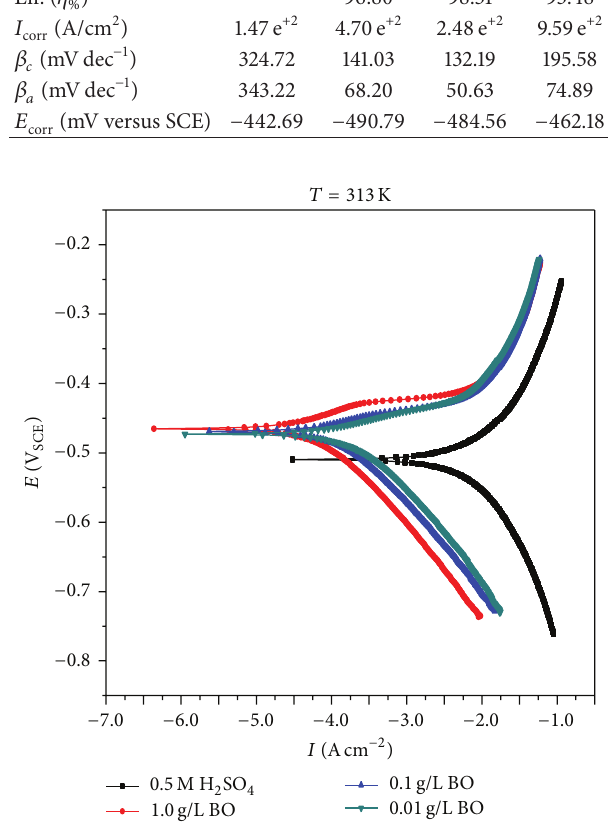
Figure 2: Potentiodynamic polarization curve for pipeline steel in 0.5 M sulfuric acid with and without different concentrations of Brassica oleracea extract at 313 K.